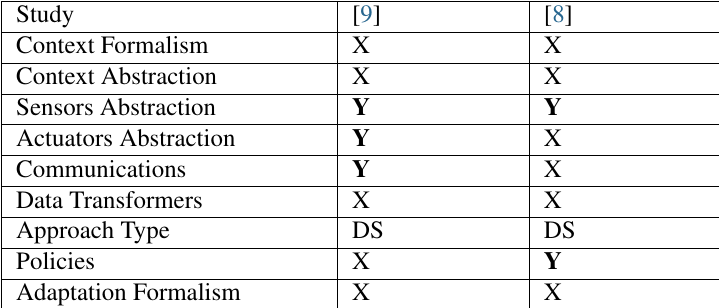
Generic approaches. Table 10. Comparison Between Context-Aware Approaches Part-3